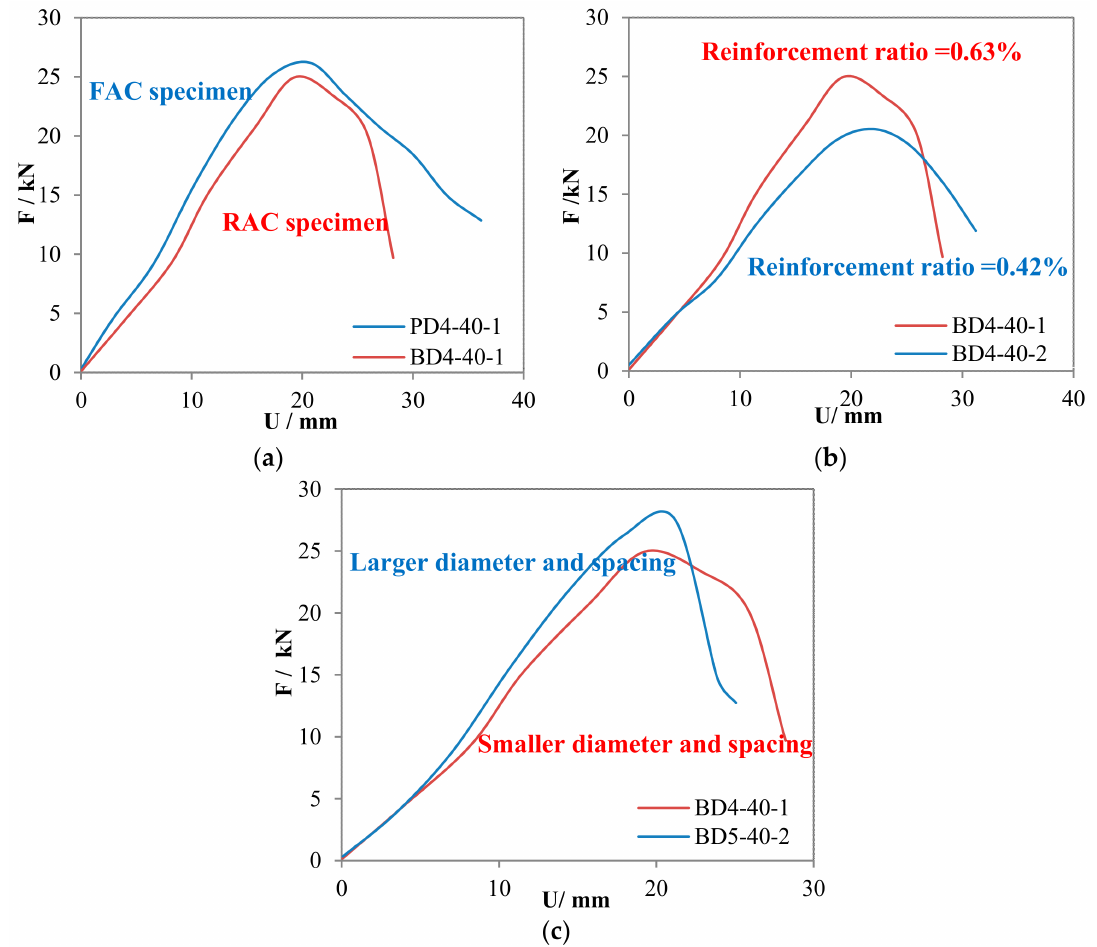
Figure 12. Effect of different parameters on the center deflection. ( a ) Effect of material types; ( b ) Effect of reinforcement ratio; ( c ) Effect of reinforcement